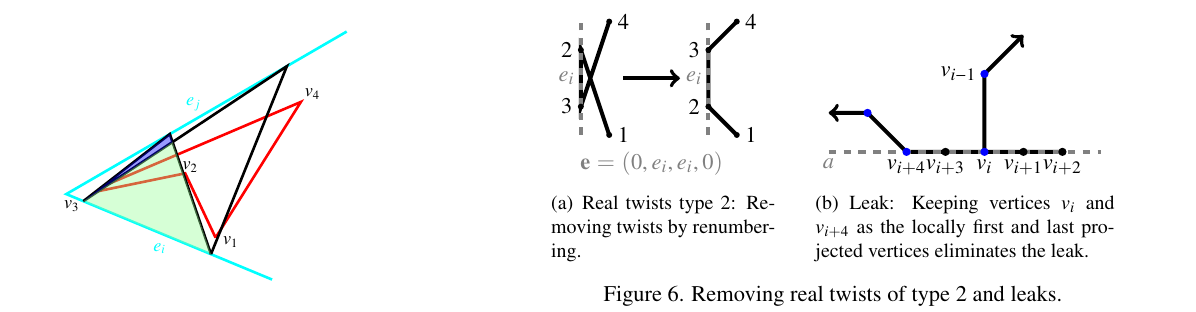
Figure 5. Ambiguous possibilities to remove the twist in the aligned polygon. By just deleting one of the vertices that are in- cident to the twisting edges, the area of the polygon will change di ff erently. Red: numbered initial P trigger , light blue: part of P target , black: resulting P trigger .